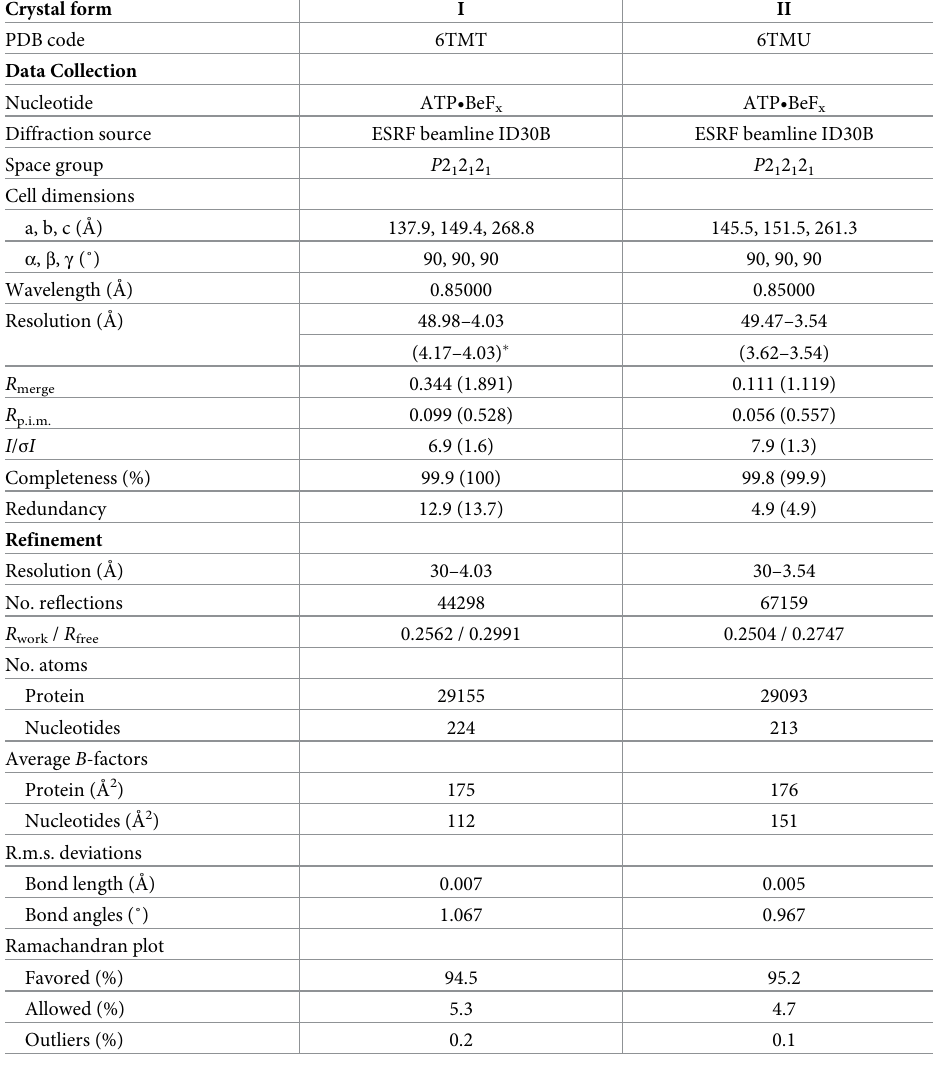
Table 1. Crystallographic data collection and refinement